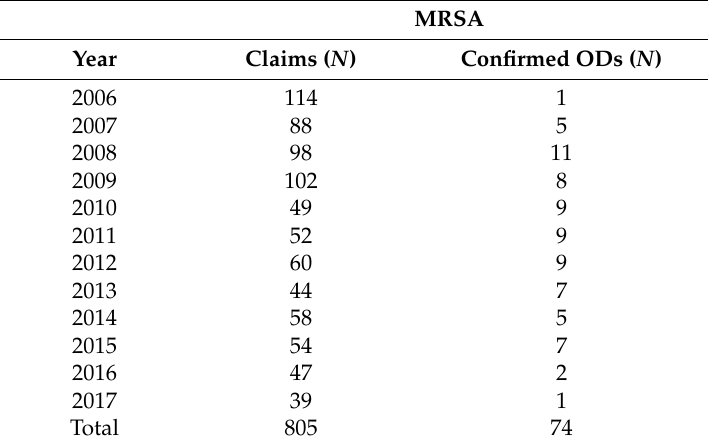
Average confirmation rate of MRSA: